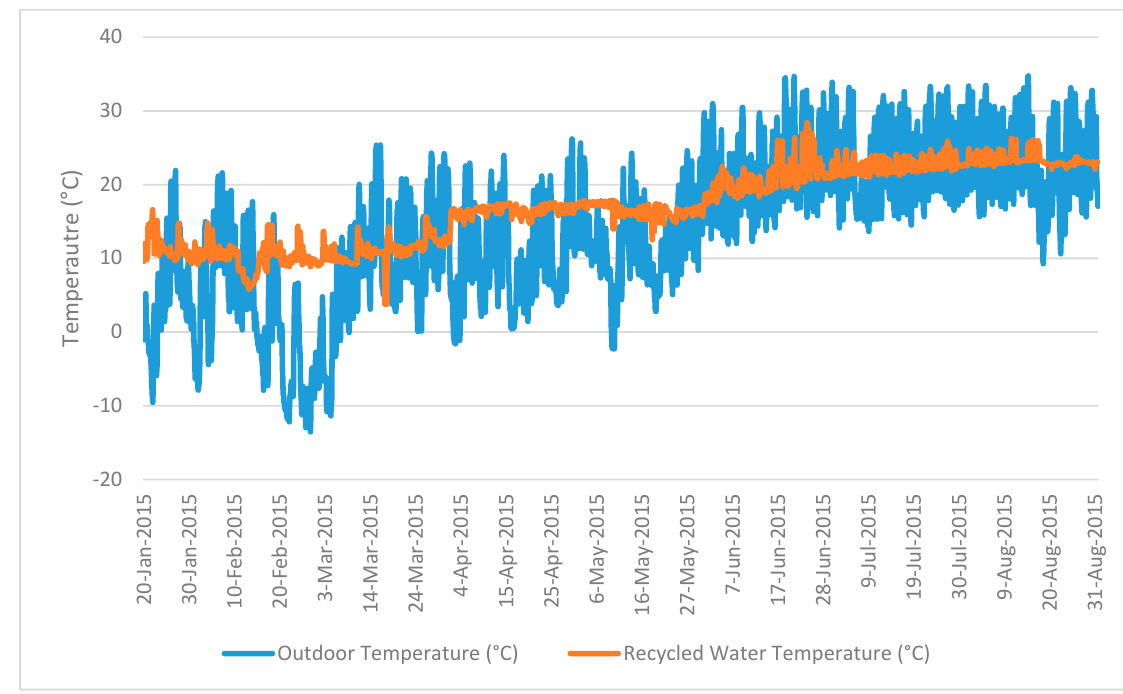
Figure 2. Hourly outdoor air (OA) temperature vs. recycled wastewater (RW) temperature.